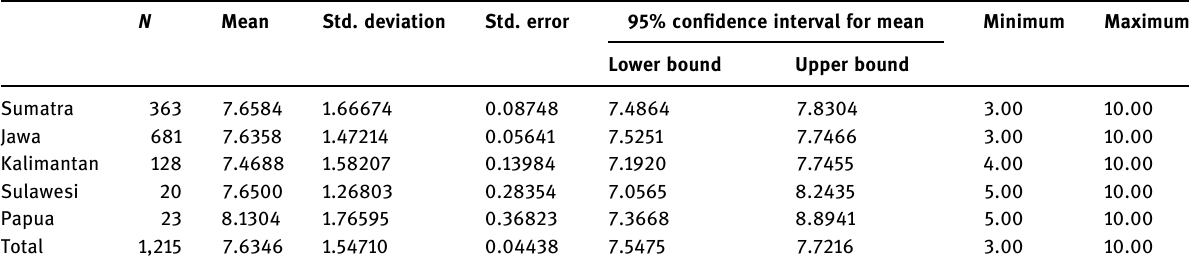
Table 10: Analysis of variance of knowledge level by island Sum of squares df Mean square F Sig. Between groups